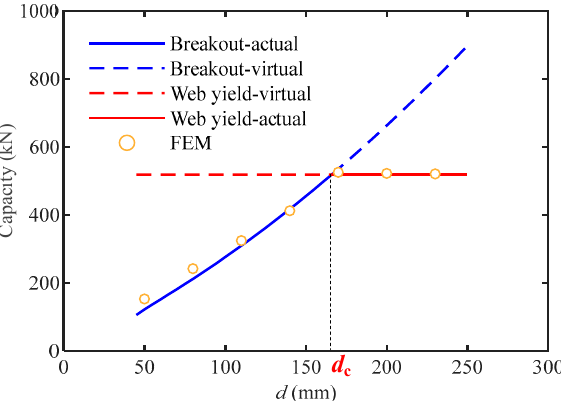
Figure 22. Pulling resistant capacity curves corresponding to the two failure modes.